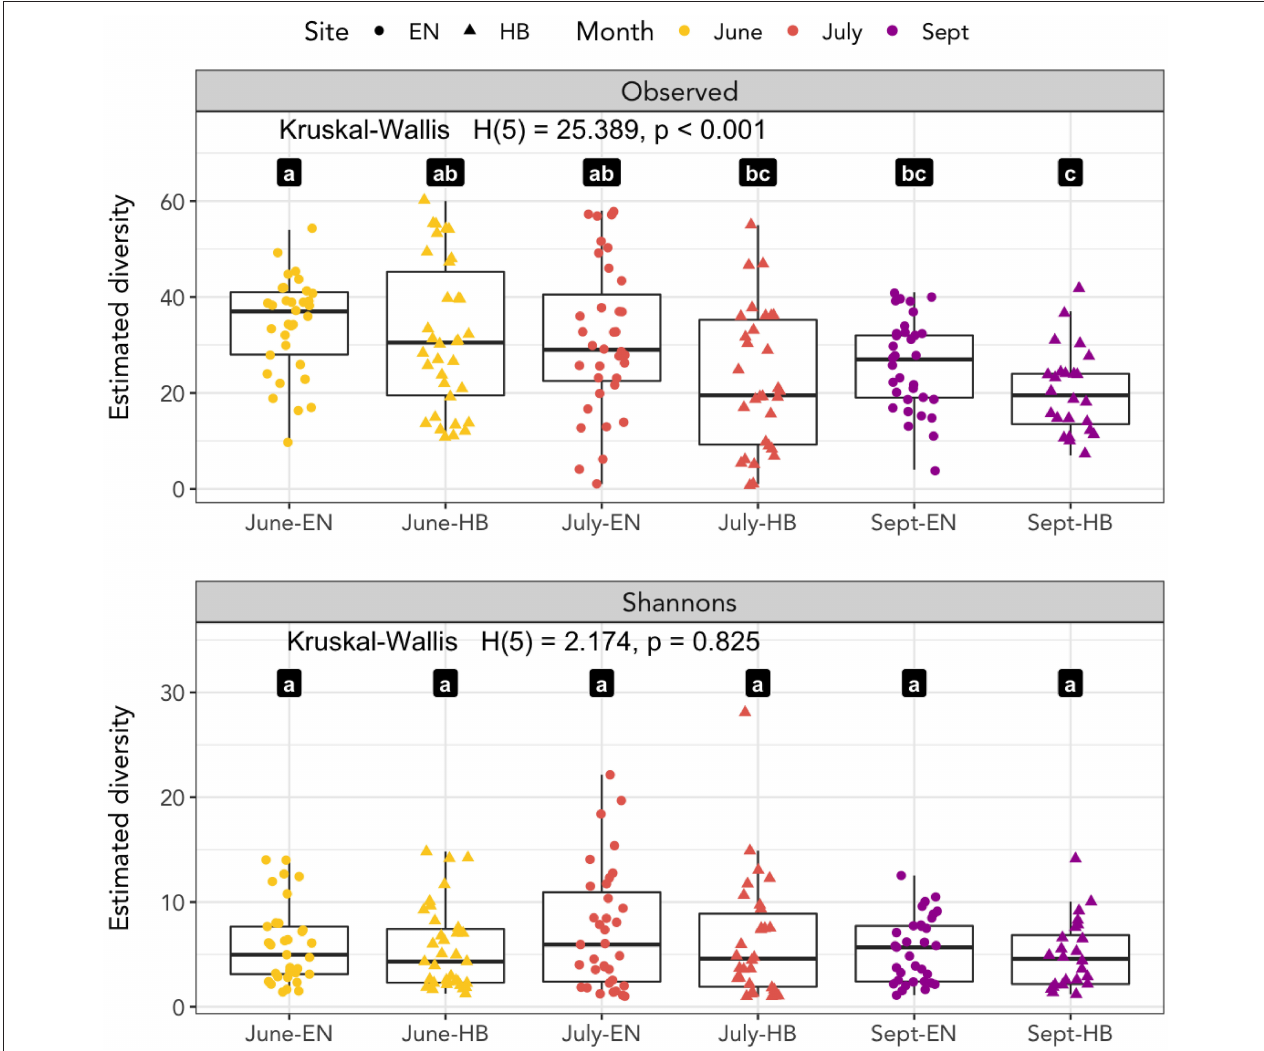
FIGURE 2 | Species richness as measured by observed richness and Shannon’s entropy. Significant differences between groups of samples collected at each site-date (Egner, “EN”; Hickory Bottoms, “HB”) represented by distinct lettered